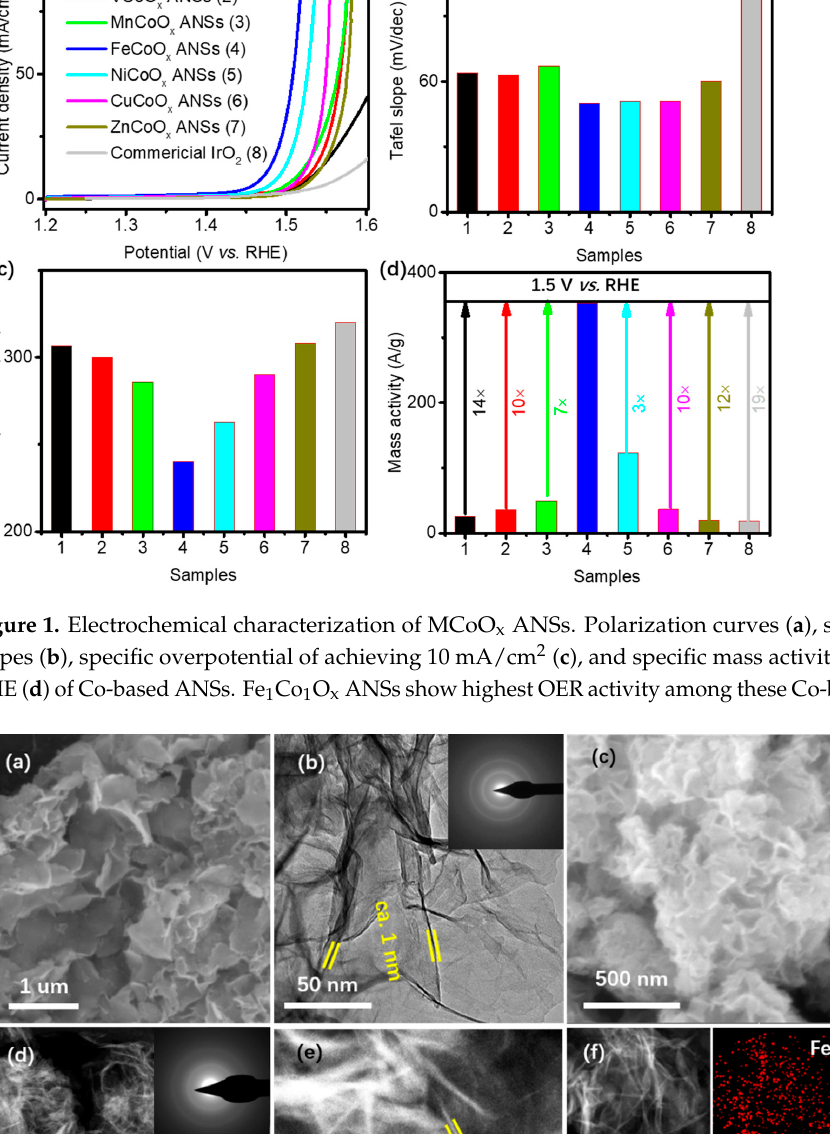
Figure 2e. EDS mapping shows the homogeneous distribution of Fe, Co, and O (Figure 2f). The ultrathin Co-based ANSs formation can be attributed to the surfactant of CTAB (with a high concentration of 0.05 M) and NaOH (with fast precipitation rate in solution, formation of amorphous MCoO x ANSs) [41]. The concentration of CTAB is above 2-fold its second micelle concentration (0.021 M) [42], leading to the CTAB micelles in reaction solution tending to form two layer structures (Scheme 1). The ultrathin layer structure and elemental homogeneous distribution of Fe 1 Co 1 O x ANSs may be caused by the fast nuclei of Fe and Co in alkaline solution during the coprecipitation process. This growth mechanism also works in synthesizing NiO x ANSs (Figures S8 and S9). Figure 2. Structural characterization of CoO x ANSs and Fe 1 Co 1 O x ANSs . SEM image ( a ) and TEM image of CoO x ANSs ( b ). Inset in ( b ) is SAED pattern of CoO x ANSs. SEM image ( c ), low magnification HAADF image ( d ), high magnification image ( e ), EDS mapping ( f ) of Fe 1 Co 1 O x ANSs. Inset in ( d ) is SAED pattern of Fe 1 Co 1 O x ANSs. The CoO ANSs and Fe 1 Co 1 O x ANSs possess similar thickness of ca. 1 nm.